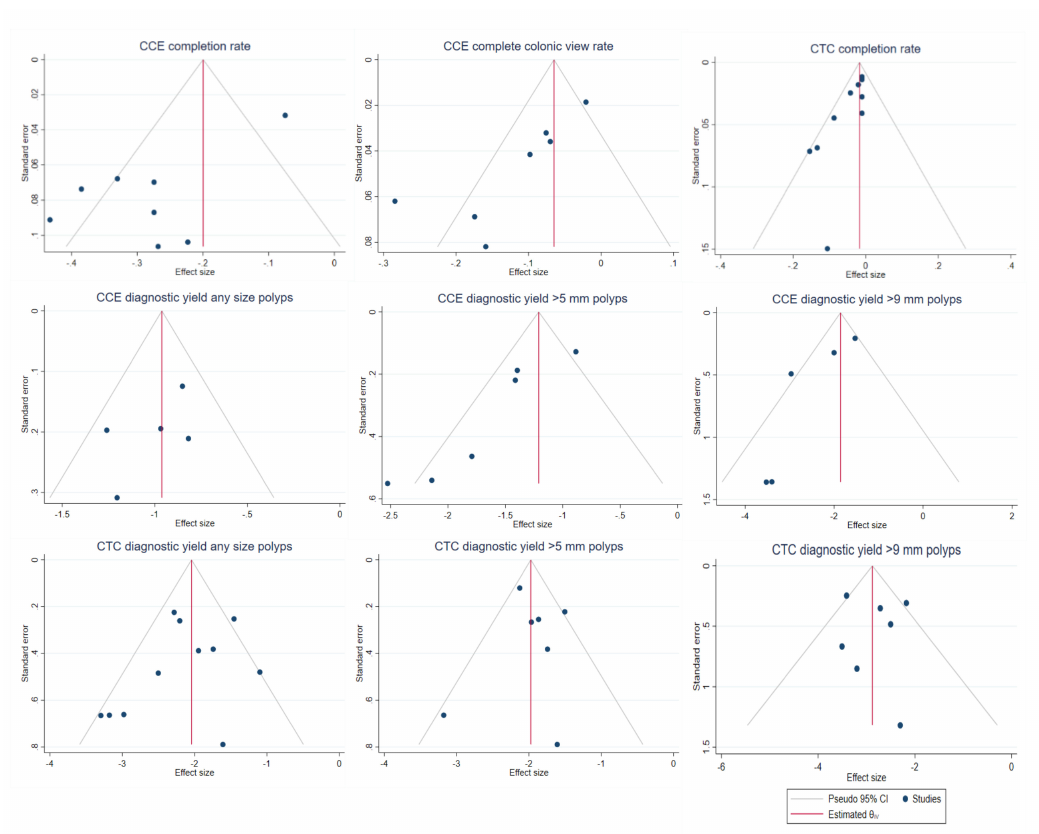
Figure A1. Funnel plots from Egger’s tests visualizing the symmetry of the e ff ect sizes within each sub-analysis from the meta-analysis on colon capsule endoscopy vs. CT colonography following incomplete